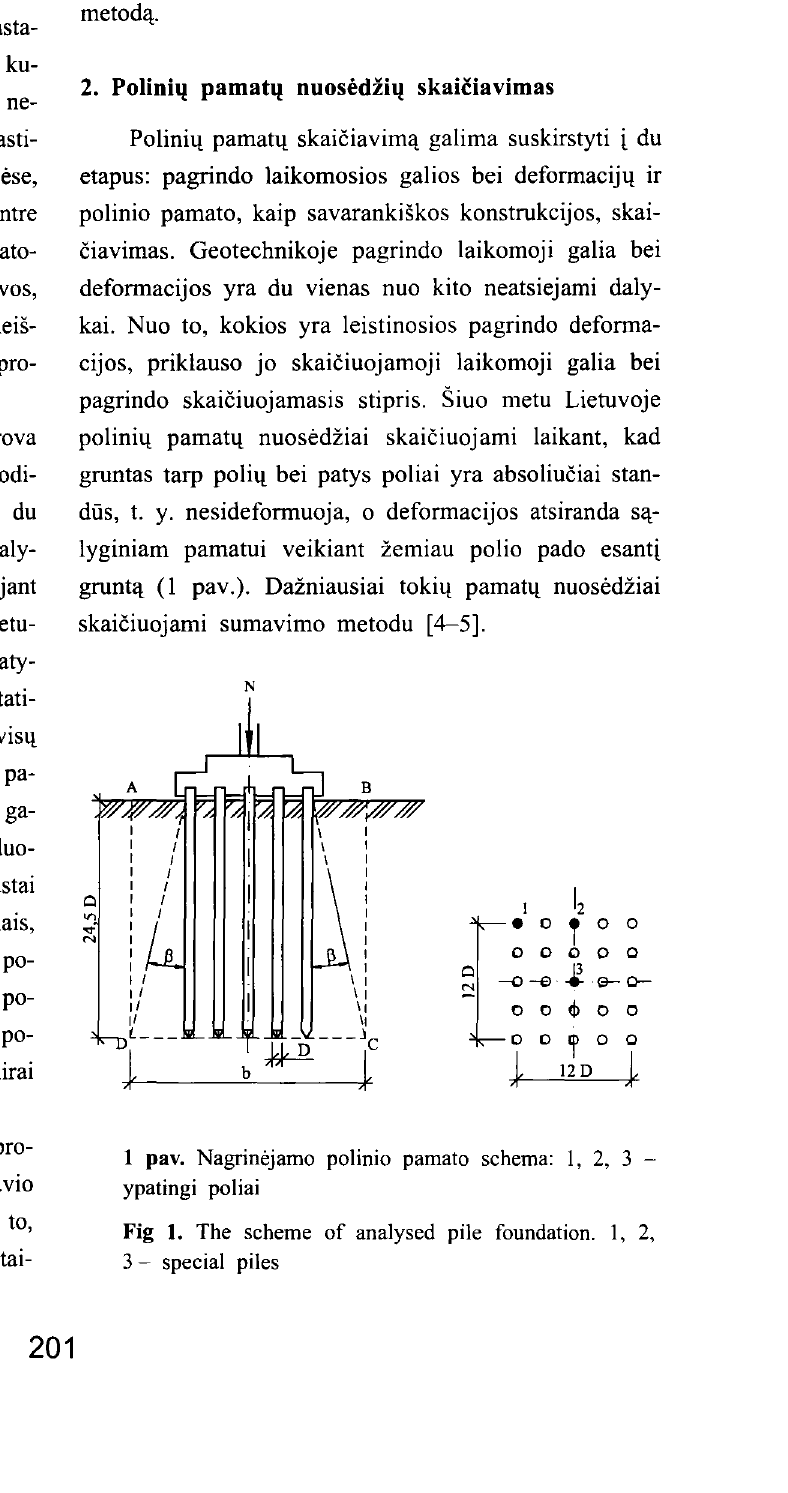
Fig 1. The scheme of analysed pile foundation. 1, 2, 3 - special